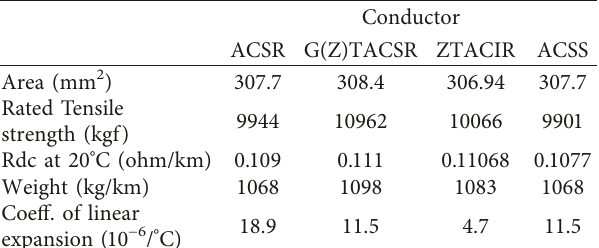
Figure 6: Comparison of sag for ACSR and HTLS temperature limit. Table 1: Electrical and mechanical characteristics of HTLS conductor.